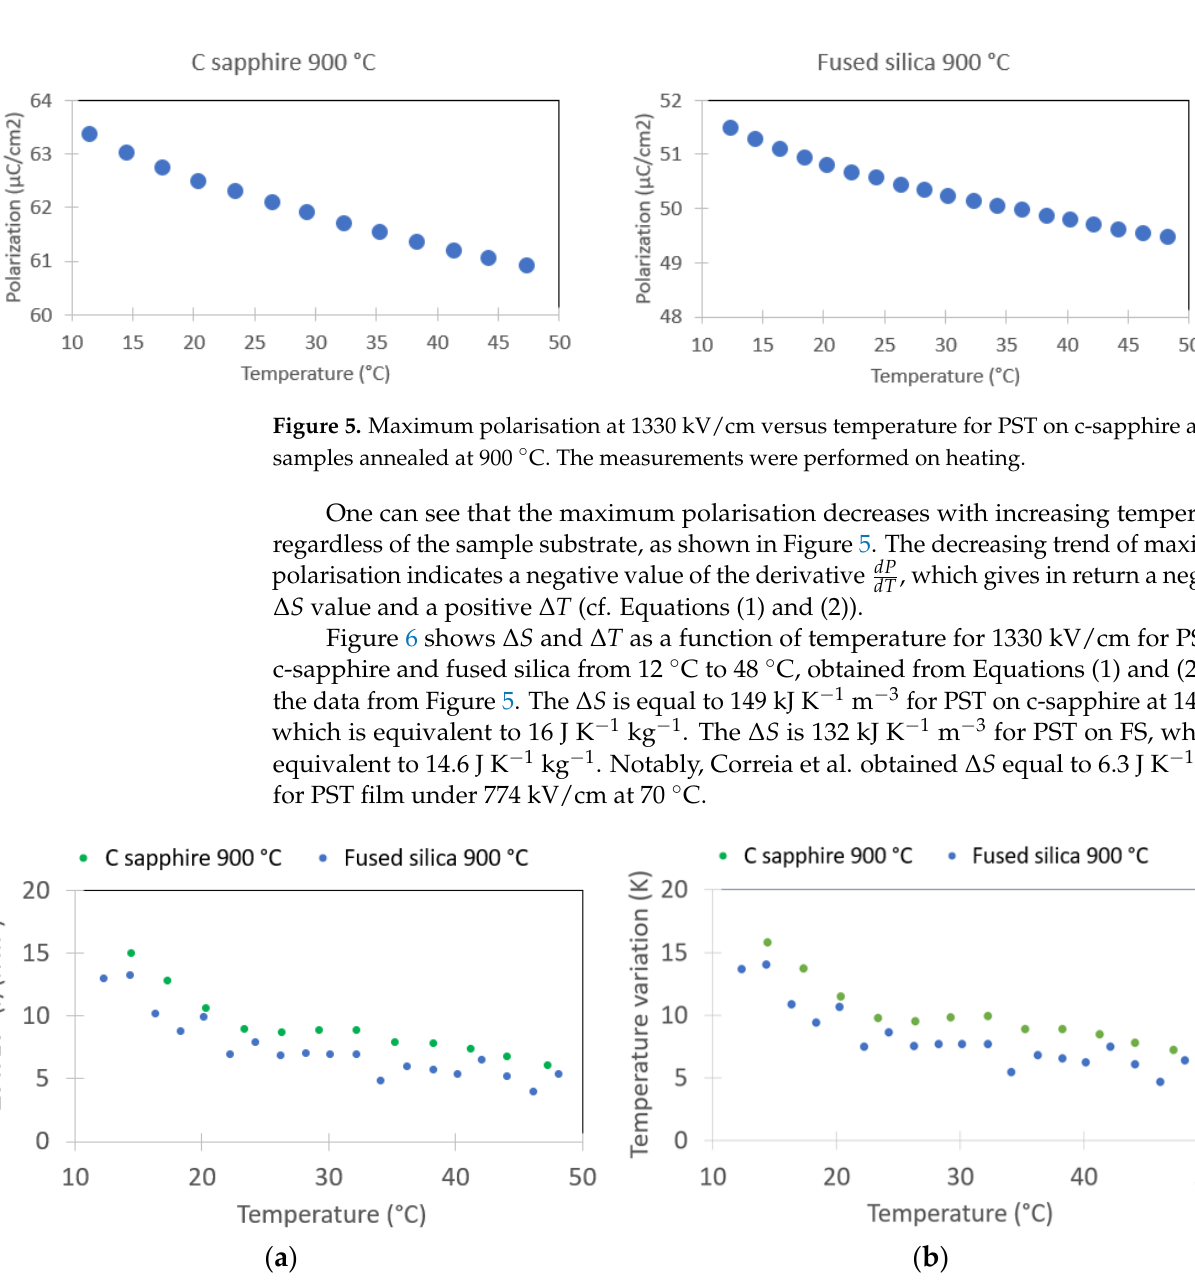
Figure 6. Calculated entropy variation ( a ) and calculated temperature variation ( b ) due to the electrocaloric effect vs. temperature. PST on fused silica and c-sapphire values correspond to 1330 kV/cm.